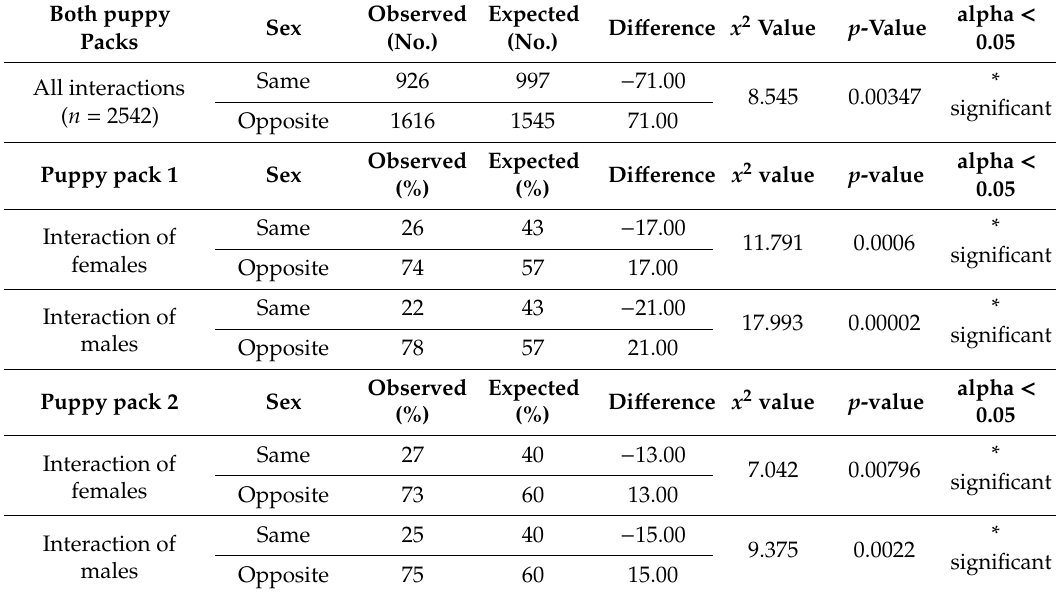
Table 4. Interactions in relation to the sex of the individuals (comparison of the same sex and the opposite sex interactions: expected vs. observed proportions or